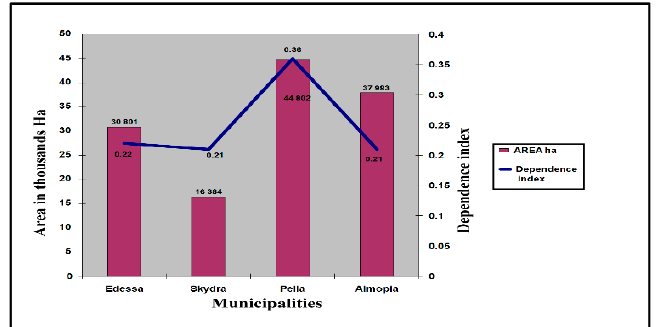
Figure 7. Covered areas and Total Dependence Index (RDI T ) values.